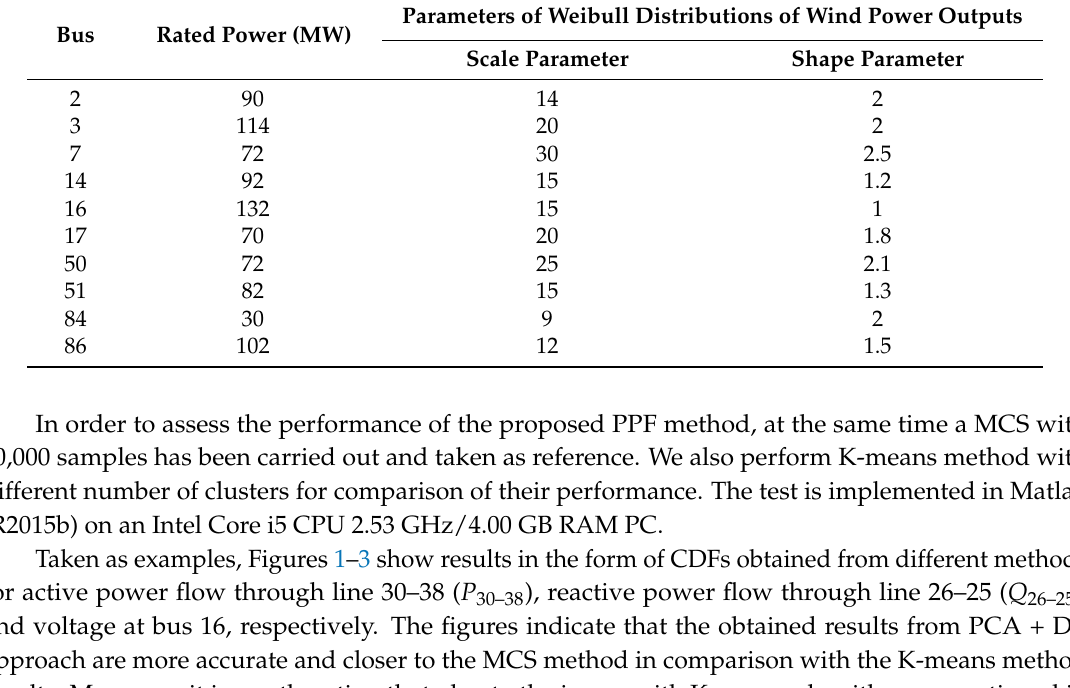
Table 1. Wind power at ten